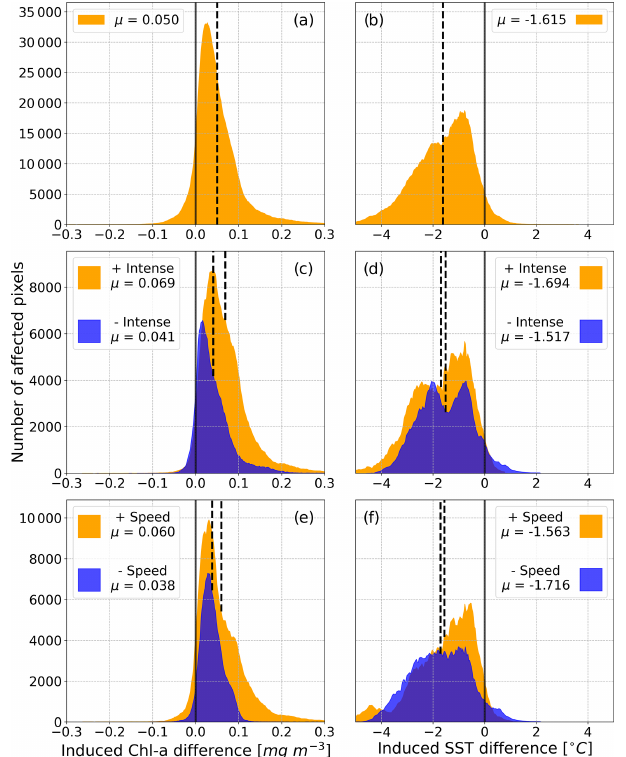
Figure 3. Histograms for (a) total Chl a and (b) SST induced anomalies; (c) Chl a and (d) SST induced anomalies after weak (blue) and powerful TCs (orange); (e) Chl a and (f) SST induced anomalies after slow TCs (blue) and fast TCs (orange). Each sub- plot histogram presents the respective population mean value ( µ ) as a dashed black line and the zero value as a grey line.